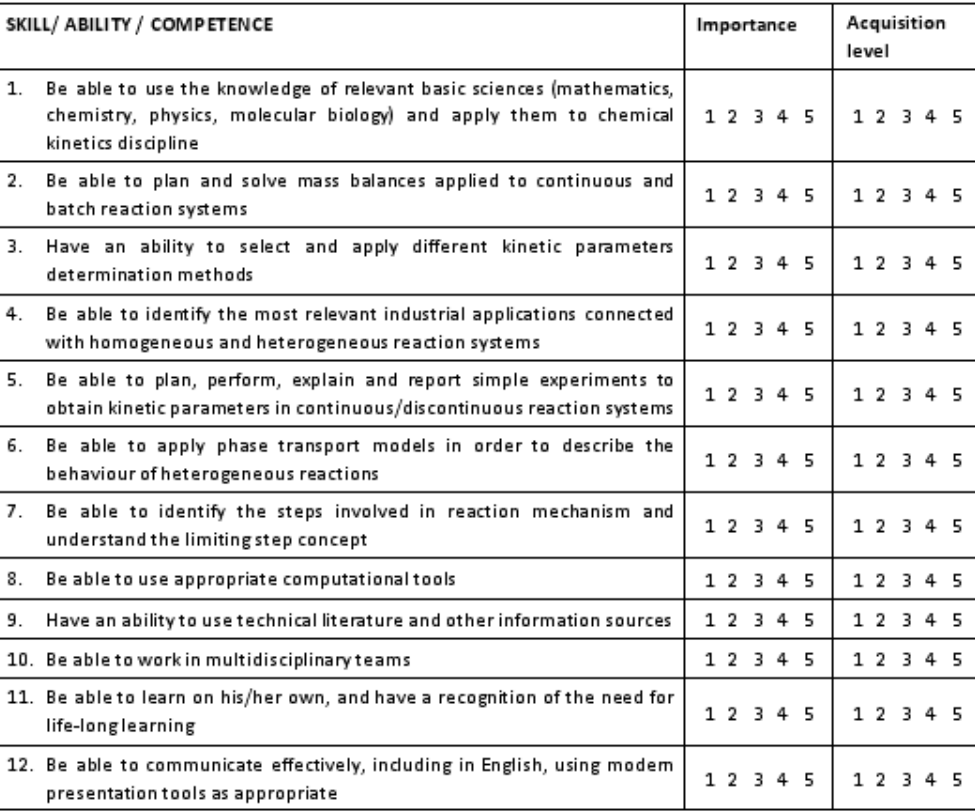
Fig 1. Skill evaluation questionnaire of the Applied Chemical Kinetics